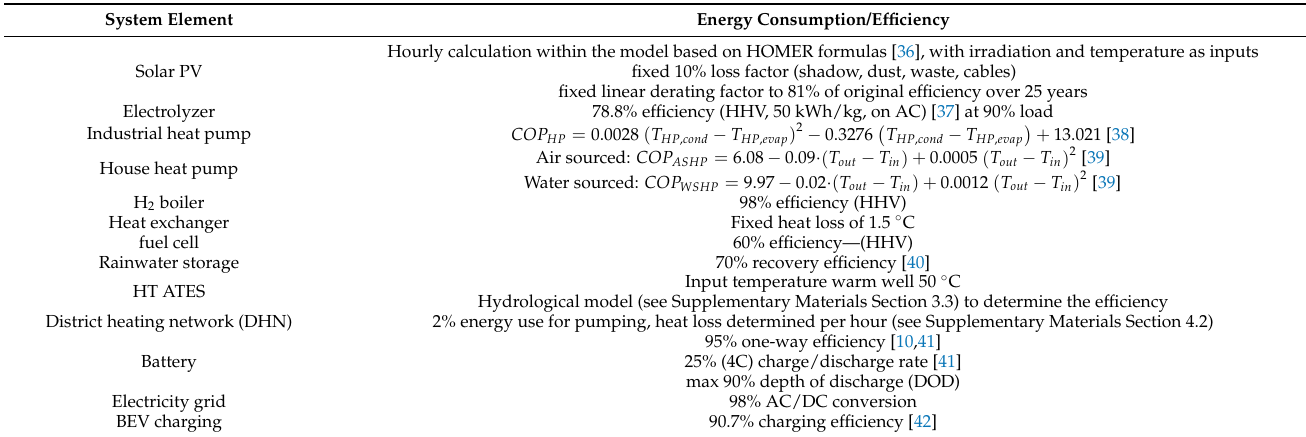
Table 1. Overview of fixed efficiency parameters in the model. A more elaborate description per system element is included in the Supplementary Information.